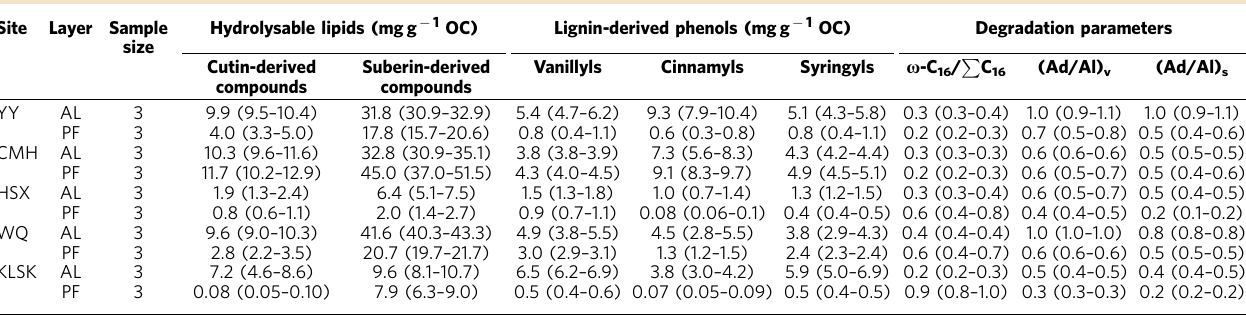
Table 1 | Chemical composition and organic matter degradation parameters of the active layer (AL) and permafrost (PF) samples at five